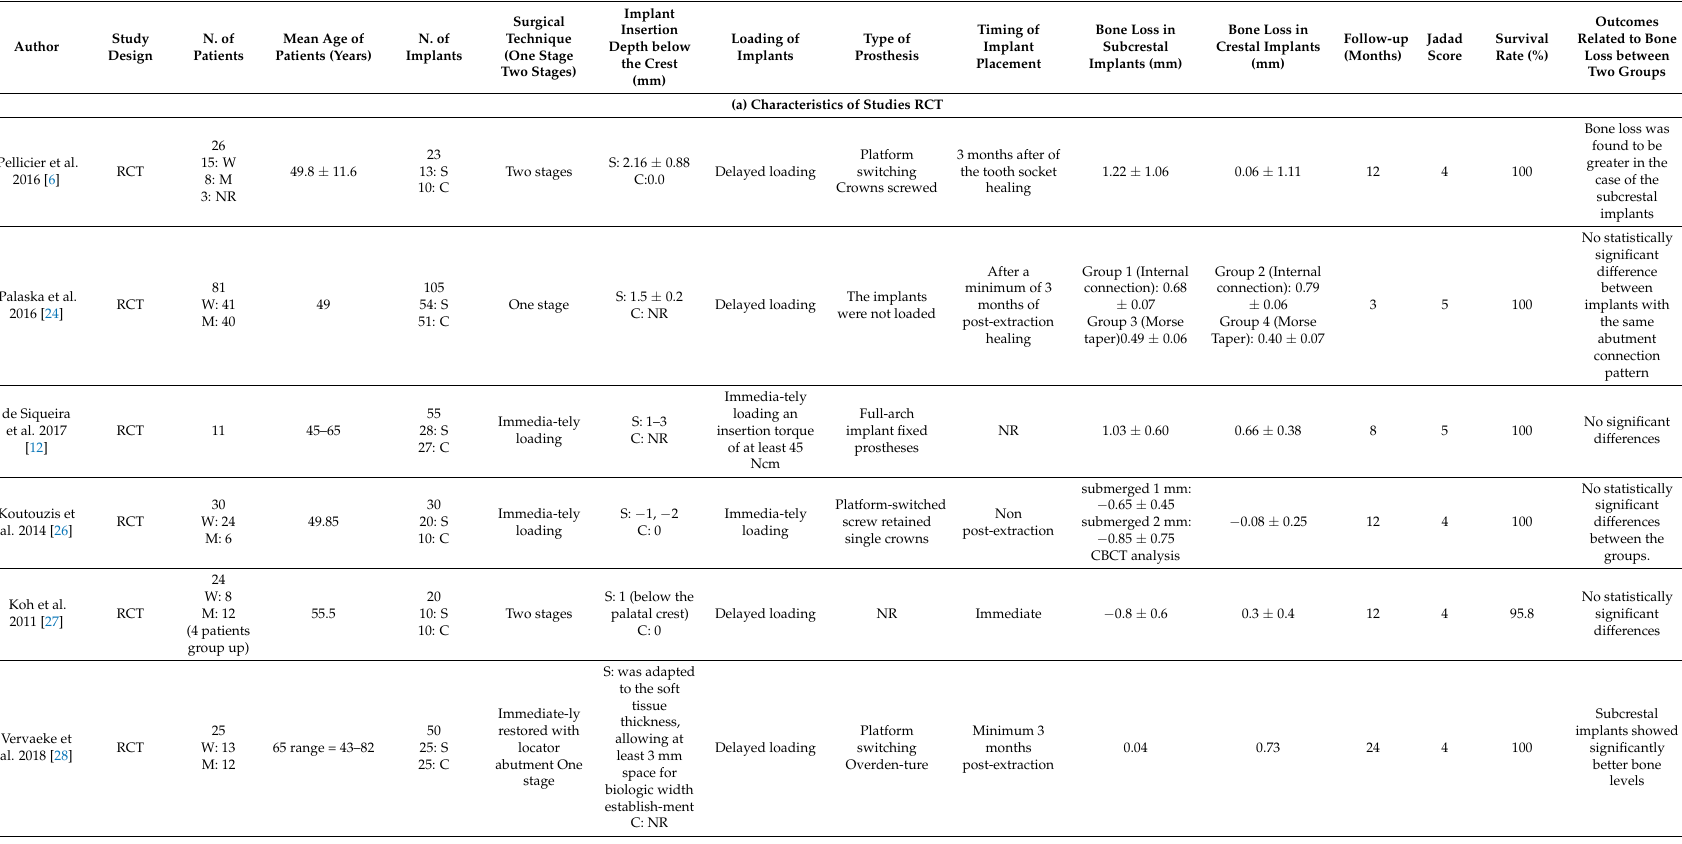
Table 2. Characteristics of studies on randomized control trials (RCT) and